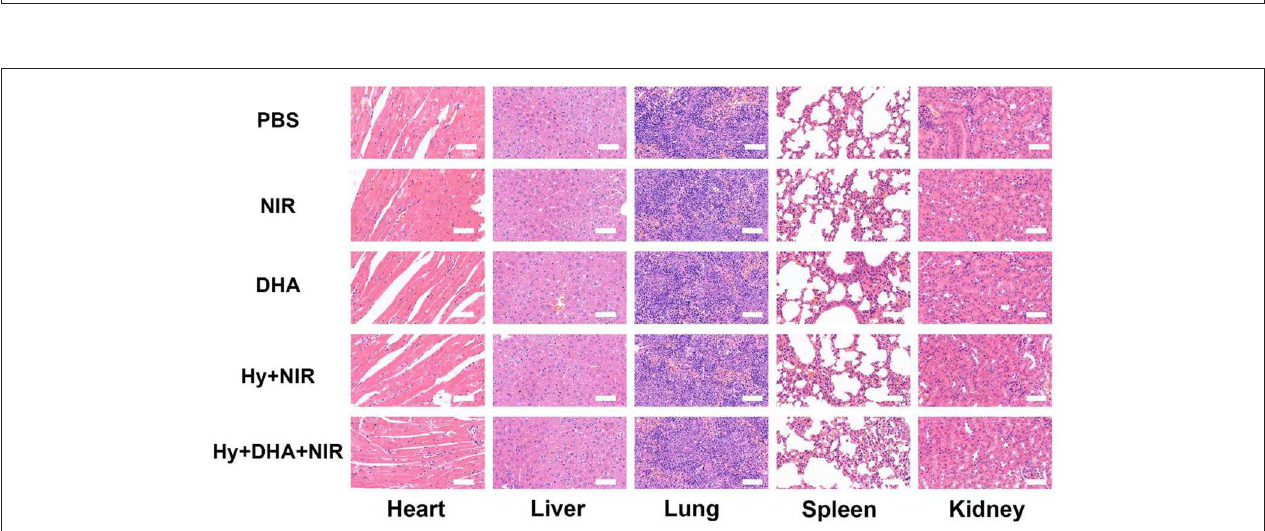
FIGURE 5 | Evaluation of the toxicity in vivo . Histological data (H&E staining) obtained in the major organs (heart, liver, spleen, lung, and kidney) of the mice 14 days after injection under various conditions. Scale bar: 100 µ m.